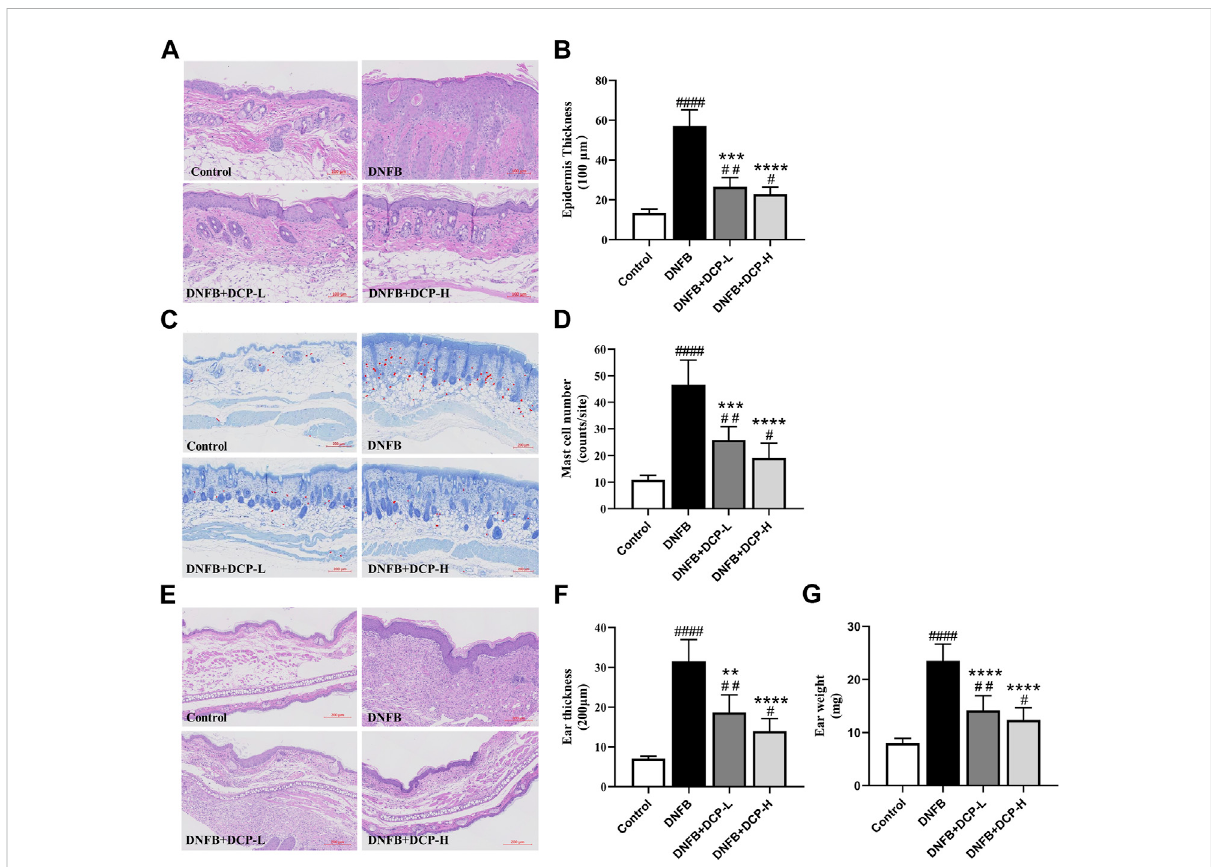
FIGURE 4 Effect of DCP on AD mice histological features of skin and ear lesions. (A,E) The skin lesions were determined by H&E; (B) Epidermal thickness was analyzed in H&E-stained tissue (scale bars, 100 μ m); (C,D) The number of mast cells was analyzed in the TB-stained sections; (F) Ear thickness was analyzed in H&E-stained tissue (scale bars, 200 μ m), (G) and ear weight was measured during the dissection. The values are shown as mean ± S.E.M. ( n = 6). ** p < 0.01, *** p < 0.001 and **** p < 0.0001 vs. the AD model group; # p < 0.05, ## p < 0.01 and #### p < 0.0001 vs. the Control